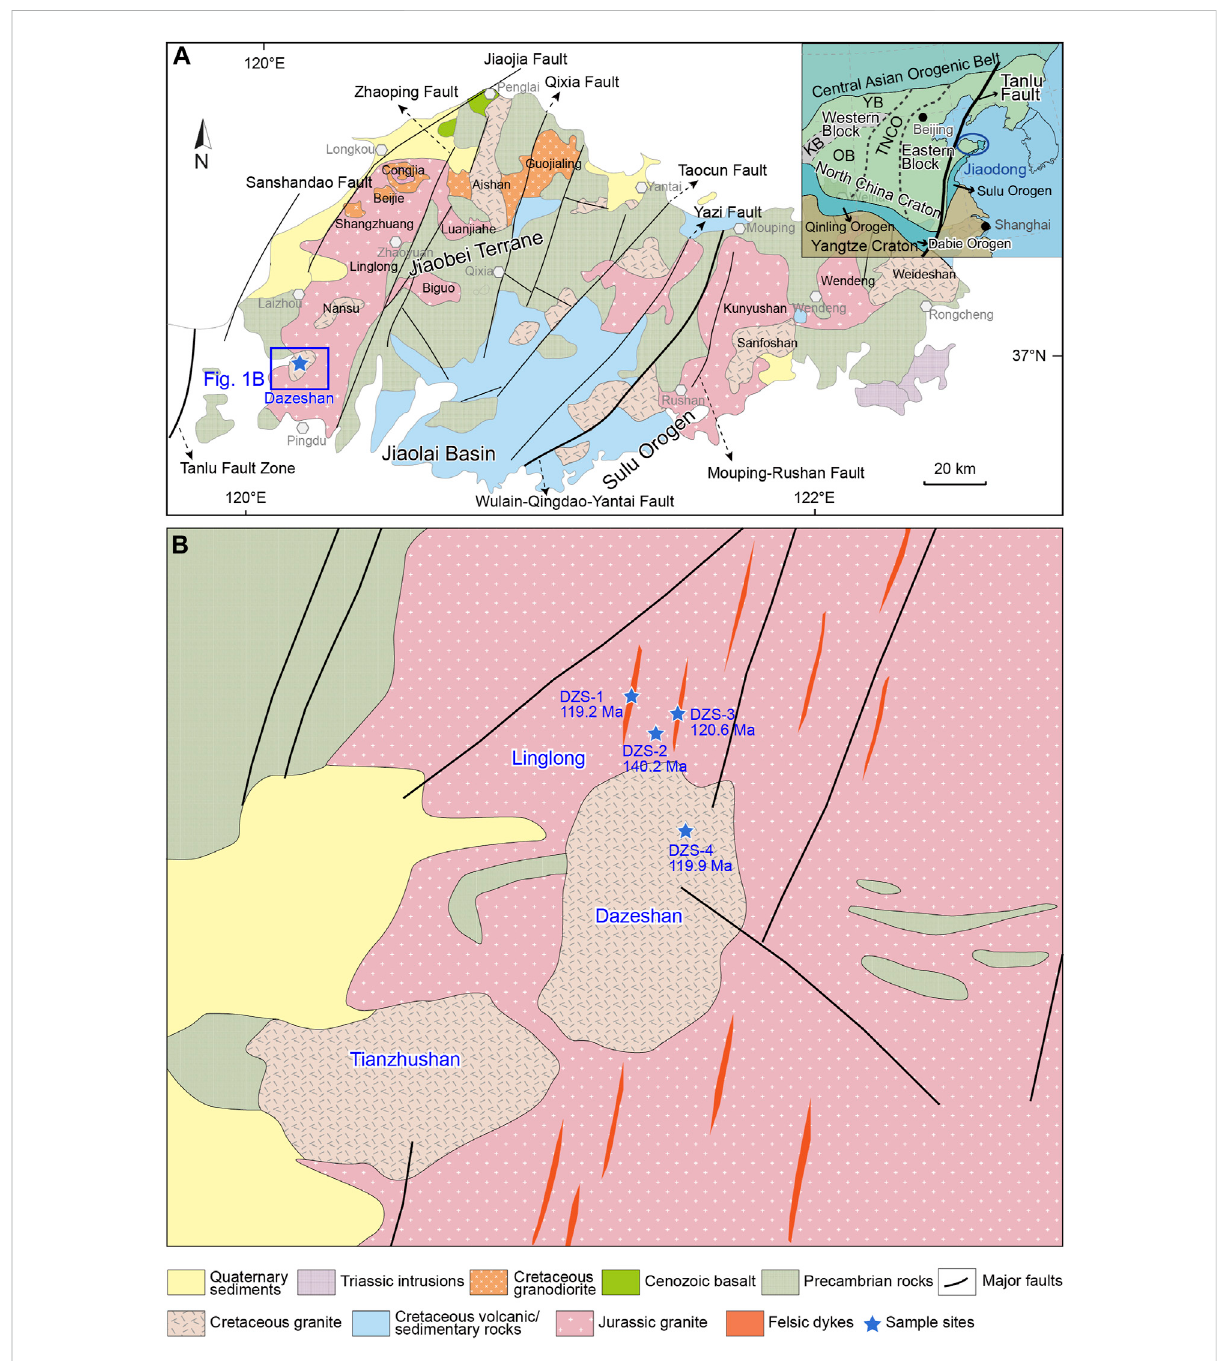
FIGURE 1 (A) Geologicalmap oftheJiaodongPeninsula,showingmajor structures,lithological units, andstudy area(Songetal.,2021). (B) TheU-Pb ages obtained in this study are noted on the